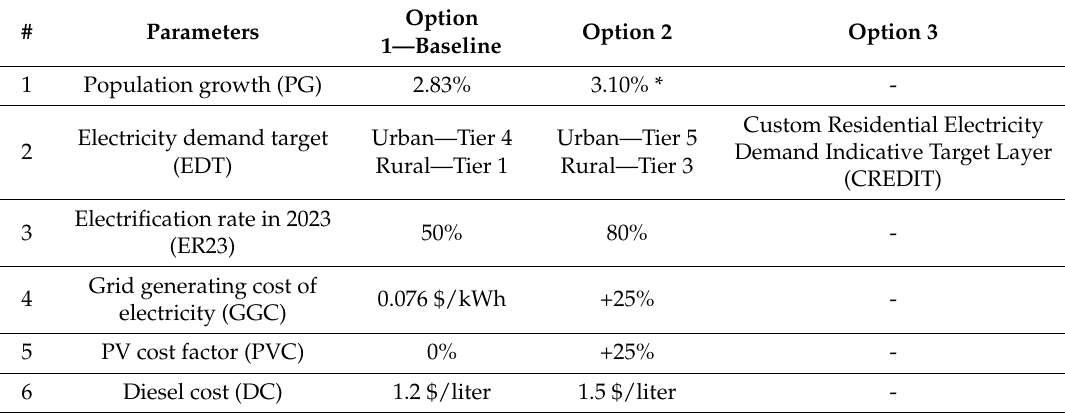
Table A5. List of parameters used in the sensitivity analysis and their selected available